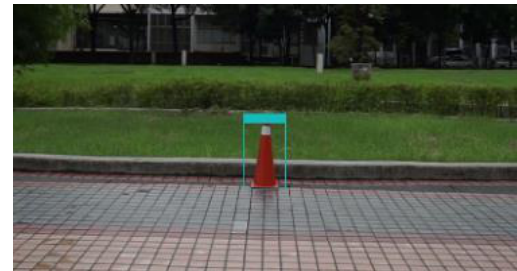
Figure 8. Cropped YOLOv3 Result (Left Image)